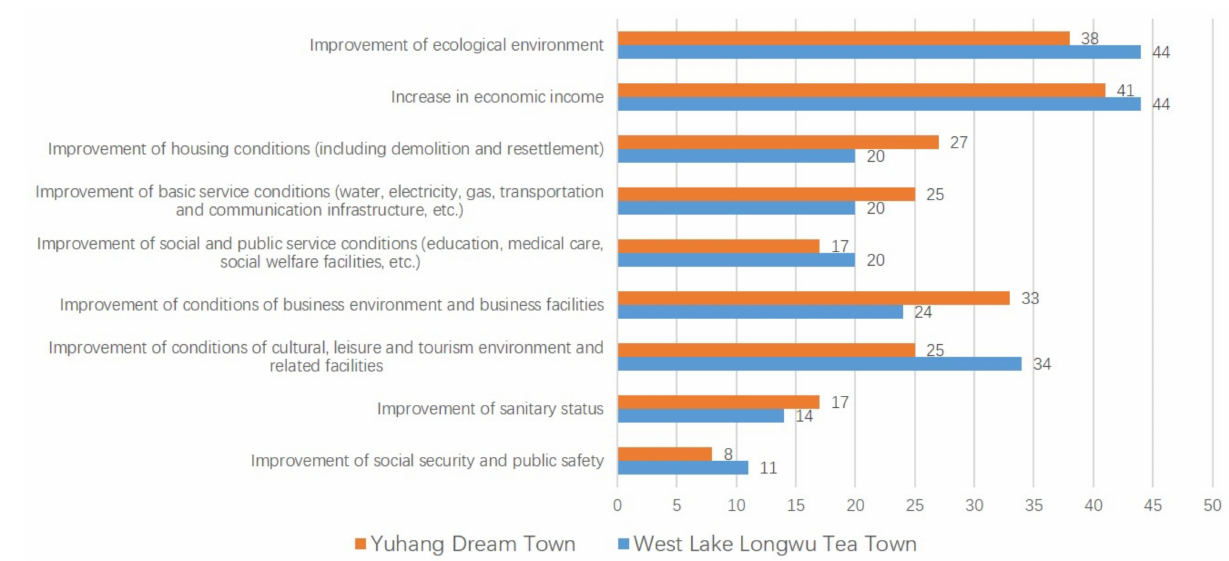
Figure 9. Frequency of selected aspects that respondents want to the CT strategy to focus on to improve the standard of living of the respondents (choose up to 4) (source: authors).